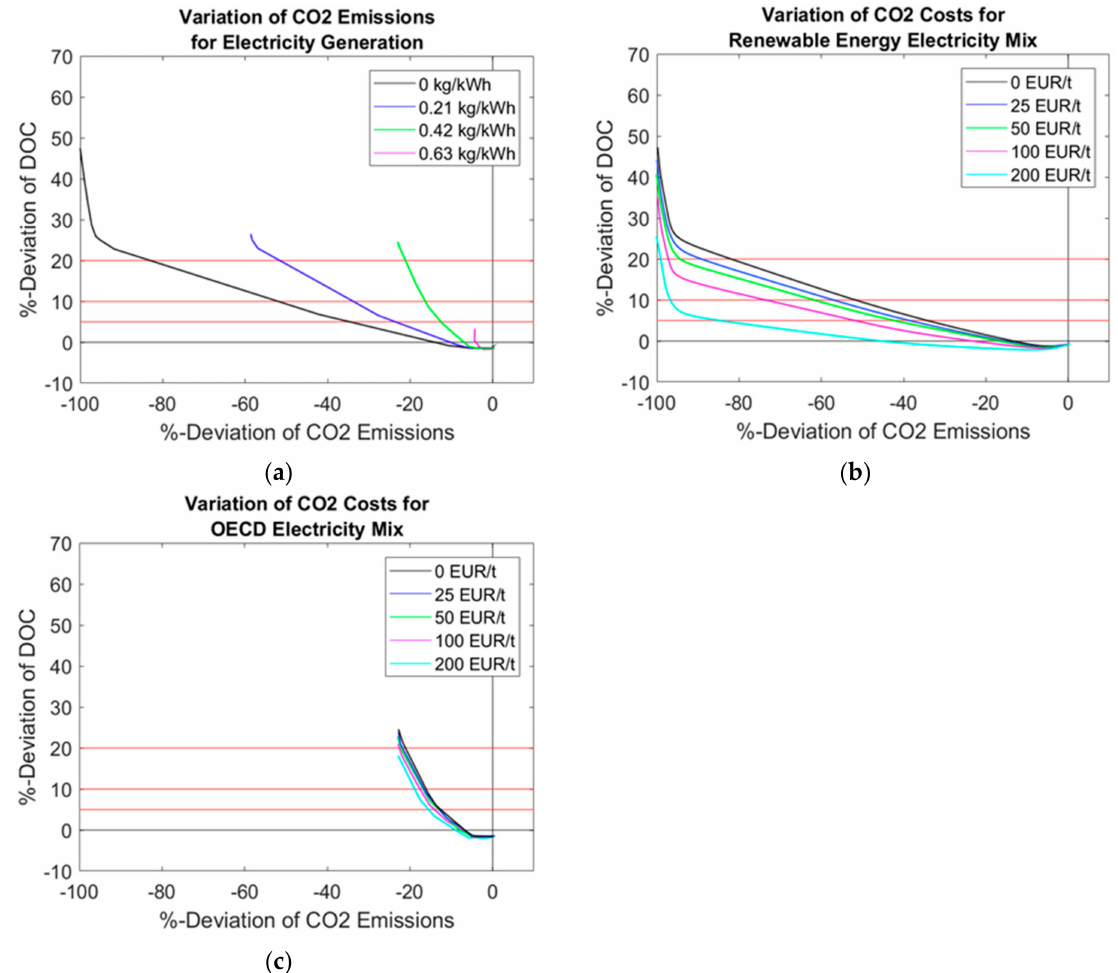
Figure 9. Sensitivity studies of CO 2 factors: PARETO-fronts for ( a ) variation of emissions of electricity generation; ( b ) OECD electricity generation mix and variation of CO 2 emission costs and ( c ) electricity from renewable energy only and variation of CO 2 emission